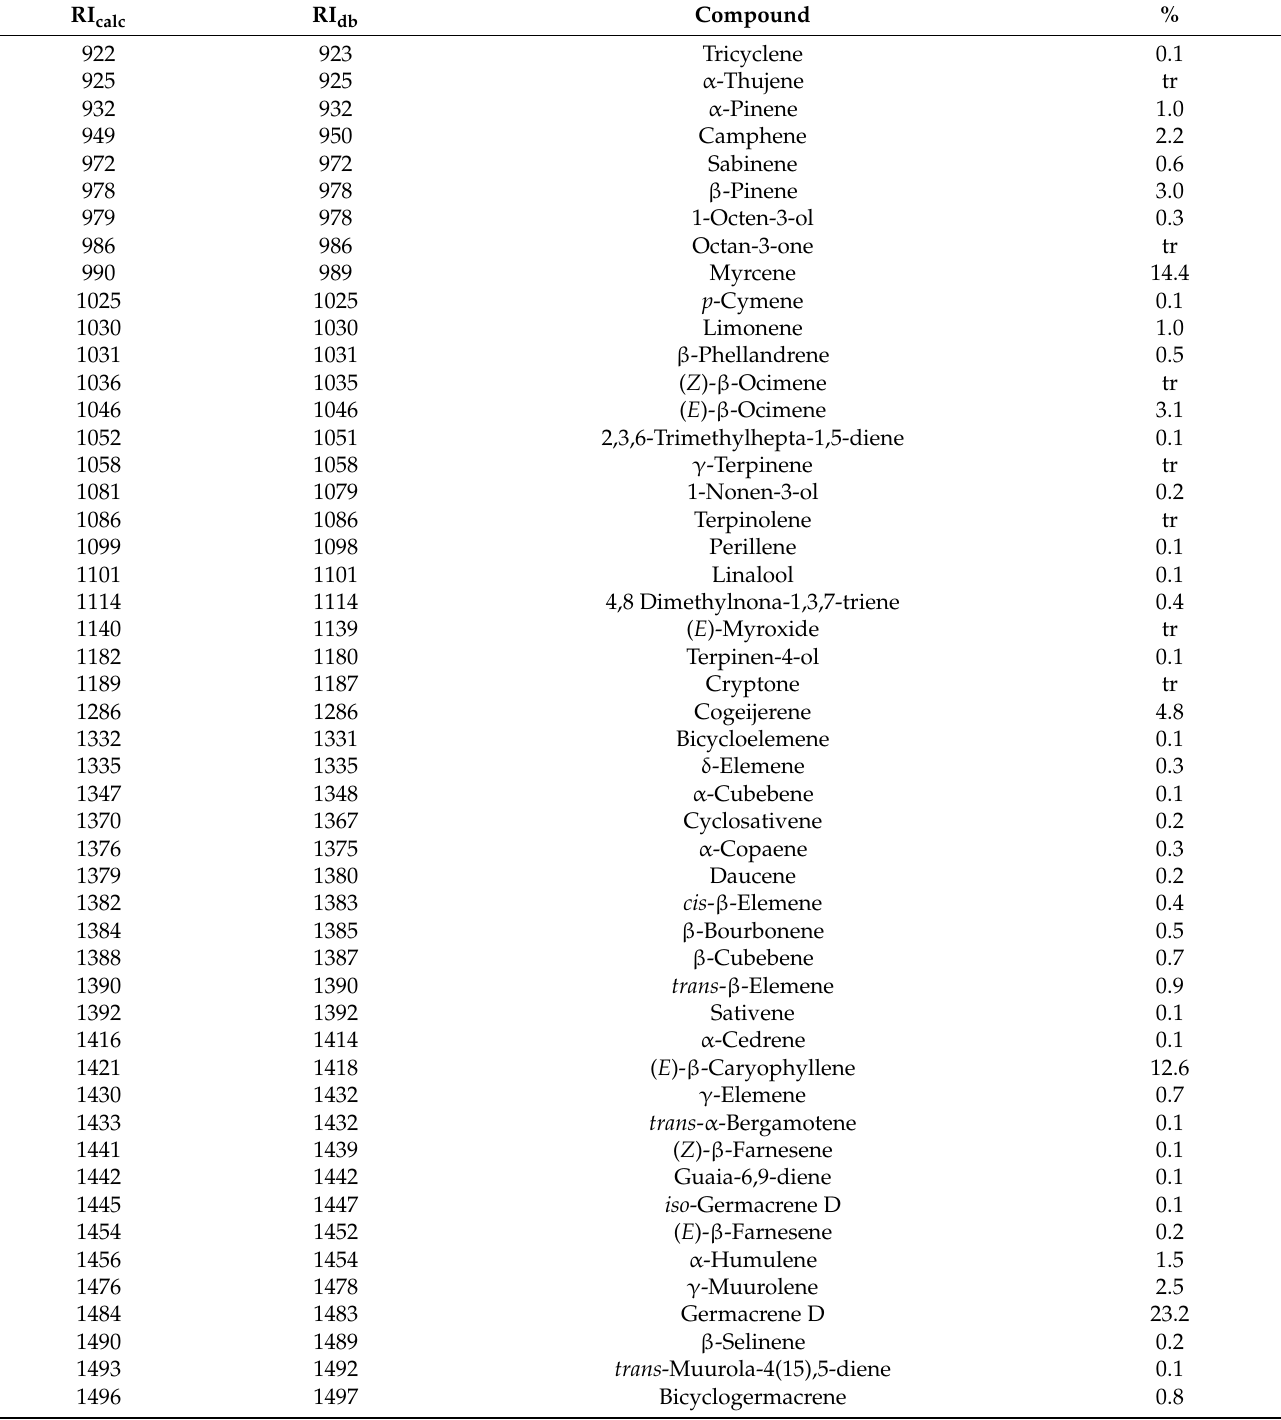
Table 4. Essential oil composition of Parthenium hysterophorus from